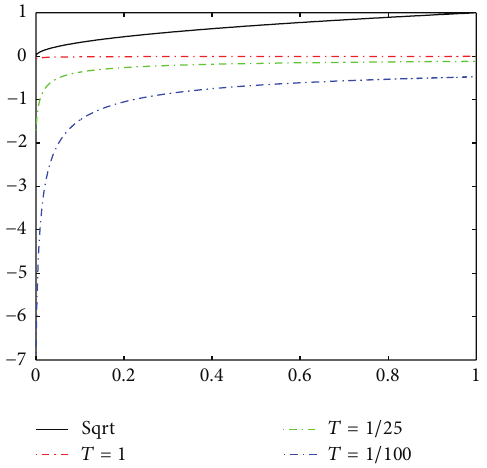
Figure 3: The outcome of the fractional signal when 𝛼 = 0.5 , 𝑇 = 1 .